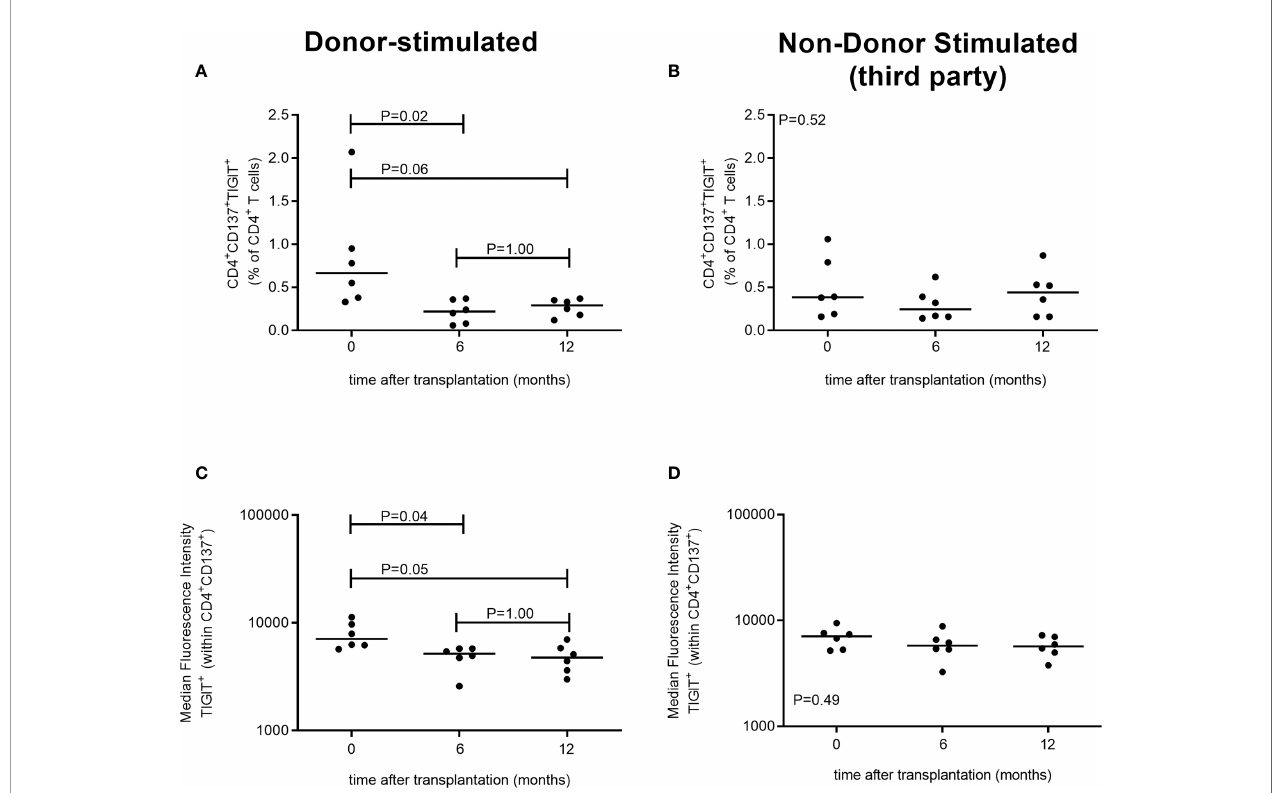
FIGURE 3 | TIGIT-expressing donor-reactive CD137+ CD4+ T cells signi fi cantly decline within fi rst 6 months following transplantation. The two panels on the left (A , B) represent PBMCs stimulated with donor-antigen while those on the left (C , D) represent PBMCs stimulated with non-donor (third party) antigen. In the top panels the percentage of CD4+ T cells co-expressing CD137 and TIGIT is illustrated prior to transplantation (timepoint 0) and at 6 and at 12 months following transplantation for 6 kidney transplant recipients per timepoint. In the bottom panels the MFI of TIGIT-expressing cells within the CD4+CD137+ T cell population is